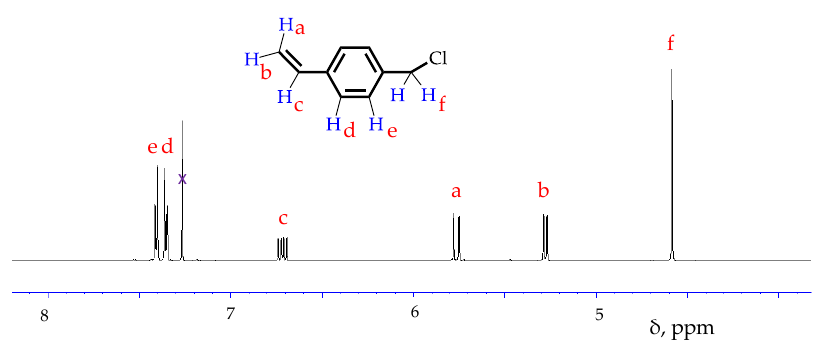
Figure 5. NMR spectrum of 4-VBC in deuterated chloroform. X — solvent peak.